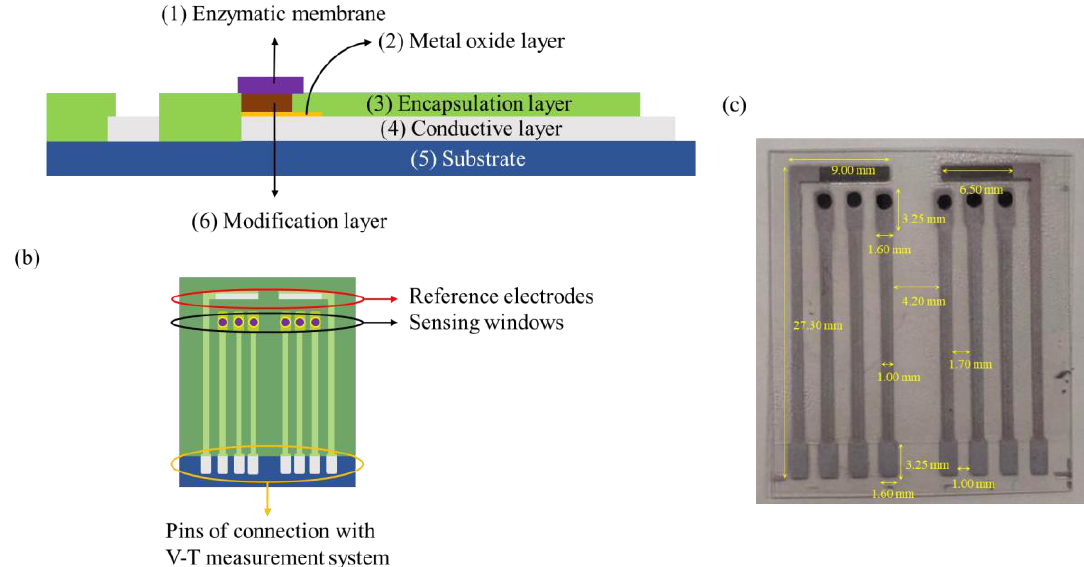
Figure 1. Schematic diagrams of the potentiometric arrayed glucose biosensor: ( a ) cross-section view and ( b ) top view. ( c ) Optical image of the potentiometric arrayed glucose biosensor based on Nafion-GOx/GO/AZO (dimensions annotated in yellow).